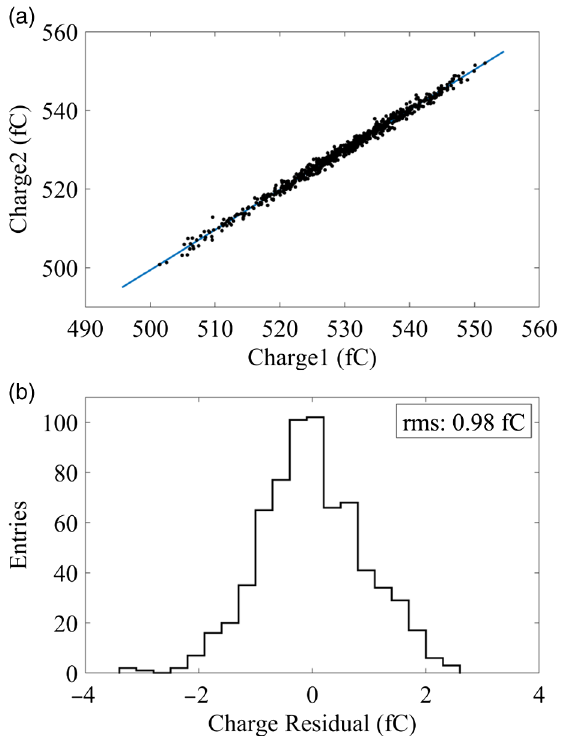
FIG. 12. Example of the baseband signals (a). Amplitude and phase waveforms calculated from the I , Q signals (b).